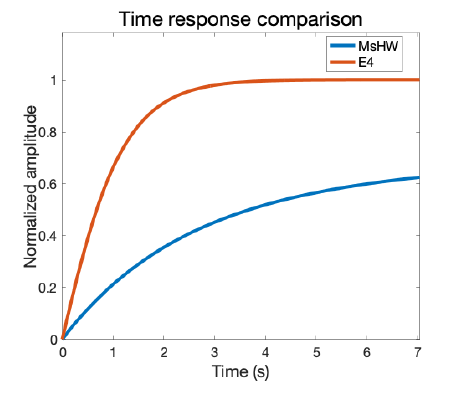
Figure 14. Time response comparison of the body temperature measurement systems. It can be clearly seen that the time response of the Empatica E4 wristband is much faster than in the case of the MsHW system. Horizontal axis: time in seconds. Vertical axis: Amplitude. Blue line: MsWH. Red line: Empatica E4